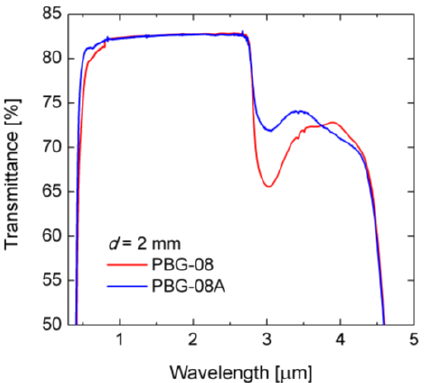
Figure 2. Characteristics of transmission for PBG-08 and PBG-08A glasses, for a 2 mm–thick sample.